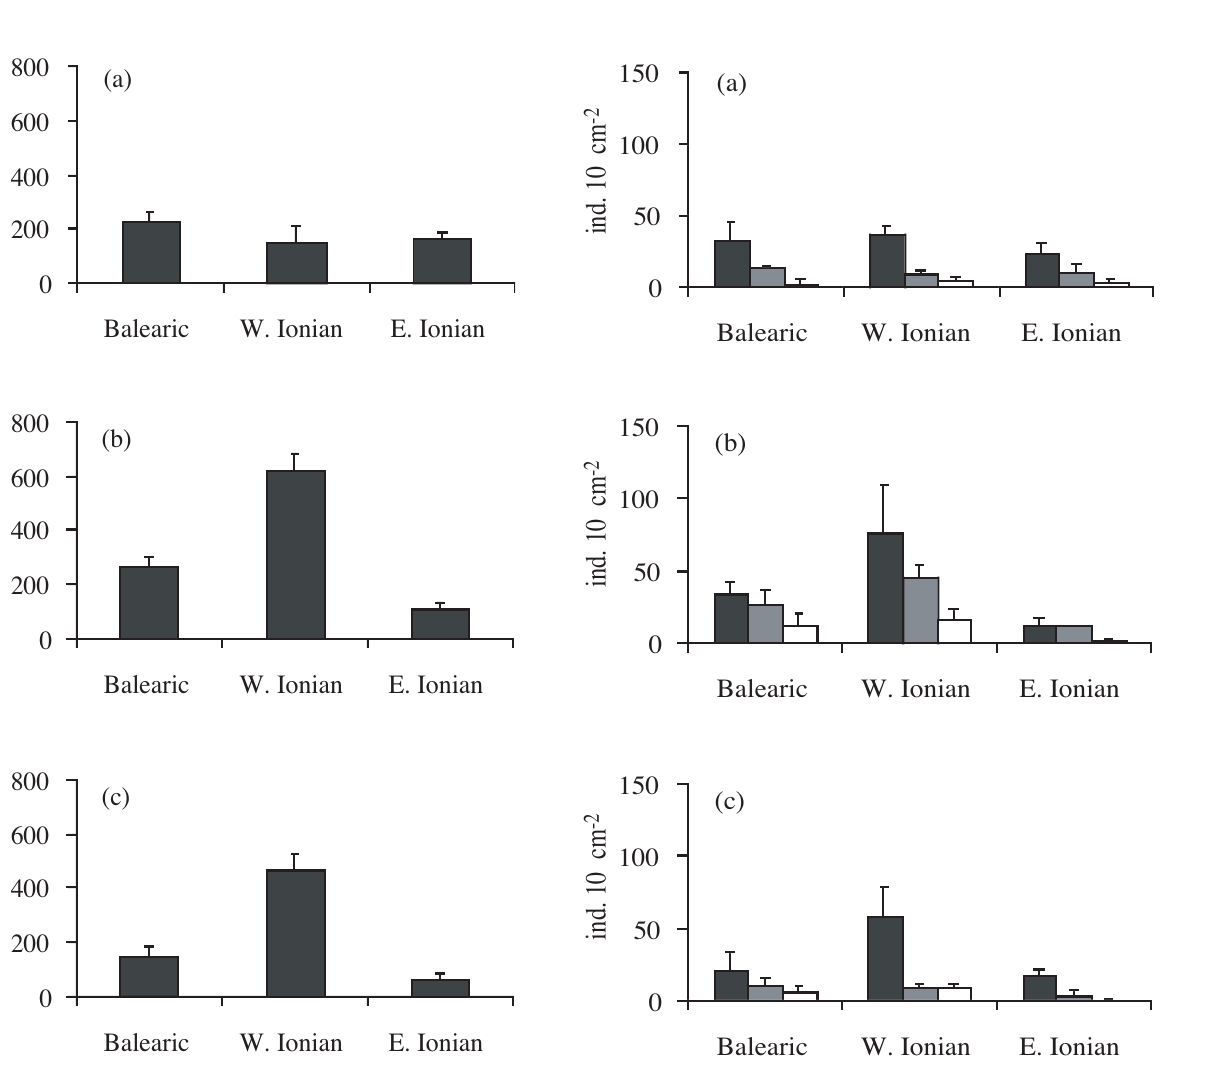
F IG . 5. – Abundance of foraminifers, adult copepods and copepod nauplii in the upper 5 cm of the sediment. (a) Stations of 600 m depth (St. 1, 7, 15); (b), Stations of 800 m depth (St. 2, 8, 16); (c), Stations of 1500-1700 m depth (St. 4, 10, 20). Black bars, foraminifers; gray bars, copepods; white bars,